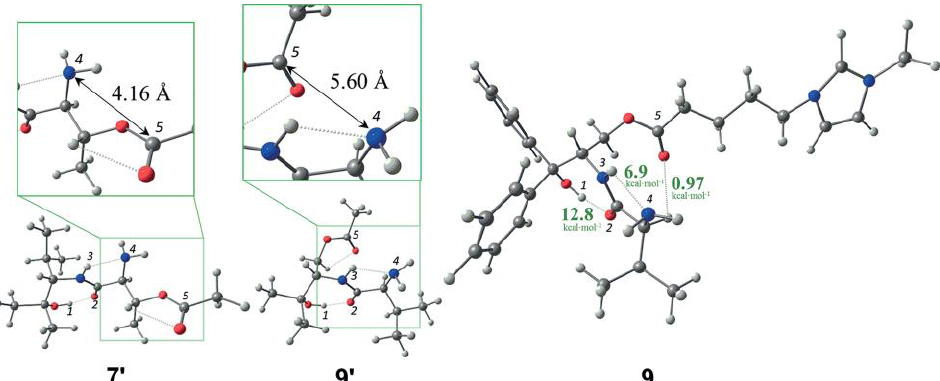
Figure 9. Minimum-energy conformers of model compounds of the five-membered transition state (7’) of 34a and the eight-membered transition state ( 9’ ) of compound 39 ( 9 ) optimized at the RIJCOSX-PBE0 – D3 – gCP/def2-TZVP SMD and PBE0 – D3/cc-pVTZ SMD energy level theory.